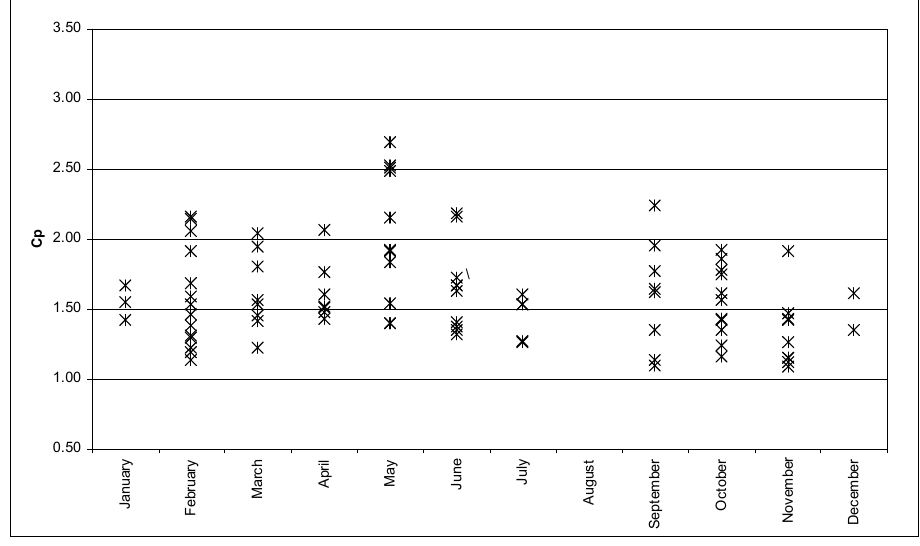
Figure 4. Peak coefficient: observed monthly variation.